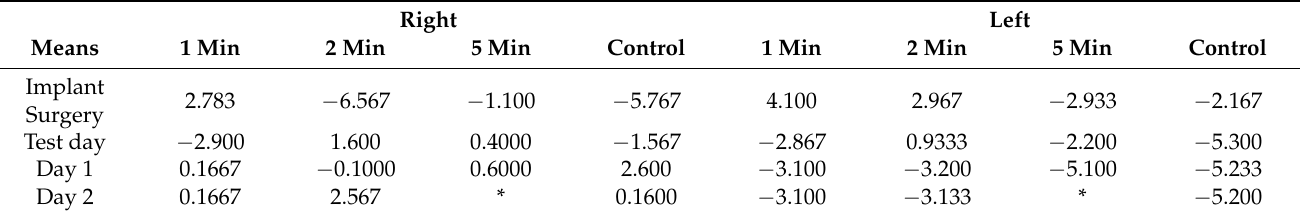
Table 10. Periotest measurements